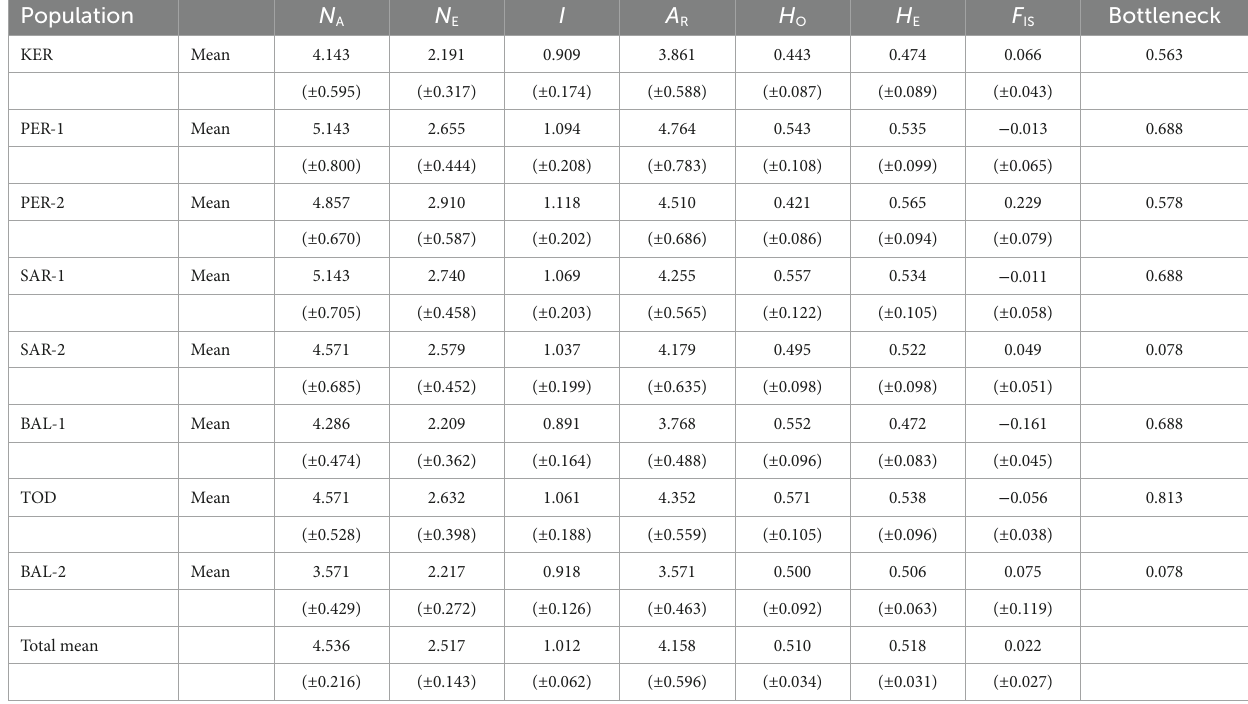
TABLE 2 Genetic statistics averaged across seven microsatellite loci for each Scots pine population. Population